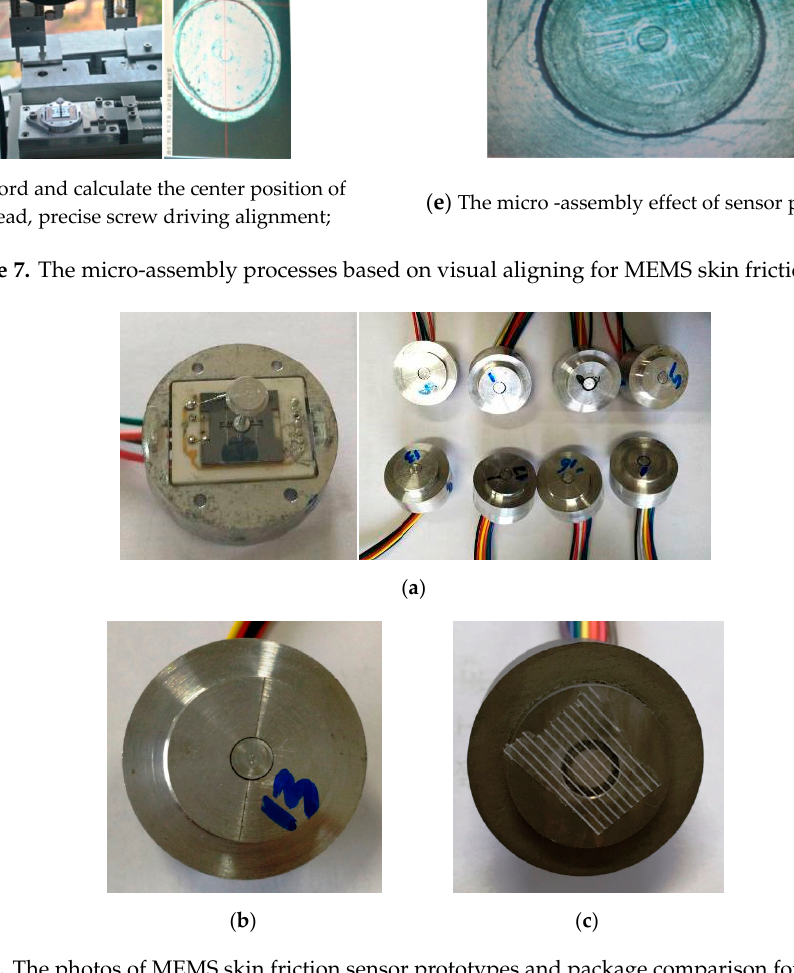
Figure 8. The photos of MEMS skin friction sensor prototypes and package comparison for two-period sensor prototypes. ( a ) Photos of sensor prototypes;( b ) Prototype based on visual alignment; ( c )Prototype assembled by hand.